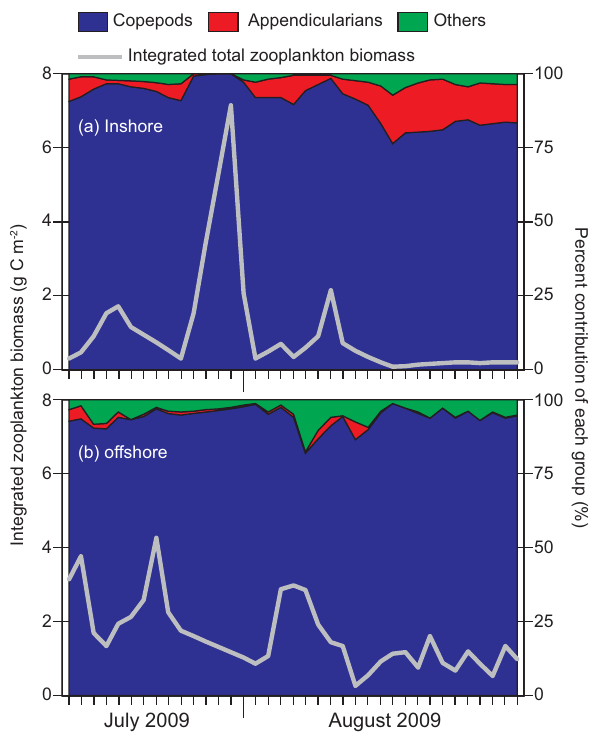
Fig. 13. Times-series from 18 July to 23 August 2009 of integrated (bottom-surface) large zooplankton biomass (gray line) and percent contribution of copepods, appendicularians and other large zoo- plankton (colors) as estimated with the UVP5 deployed at stations located within (a) or beyond (b) the shelf break (100m isobath) dur- ing the ArcticNet-Malina campaign. For further information on the mesozooplankton community structure and detailed composition in the southeast Beaufort Sea during the period of July–August 2009, please see Forest et al.